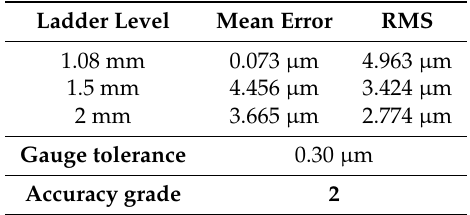
Table 2. Error analysis of gauge ladder with compensation ratio 0.9948.